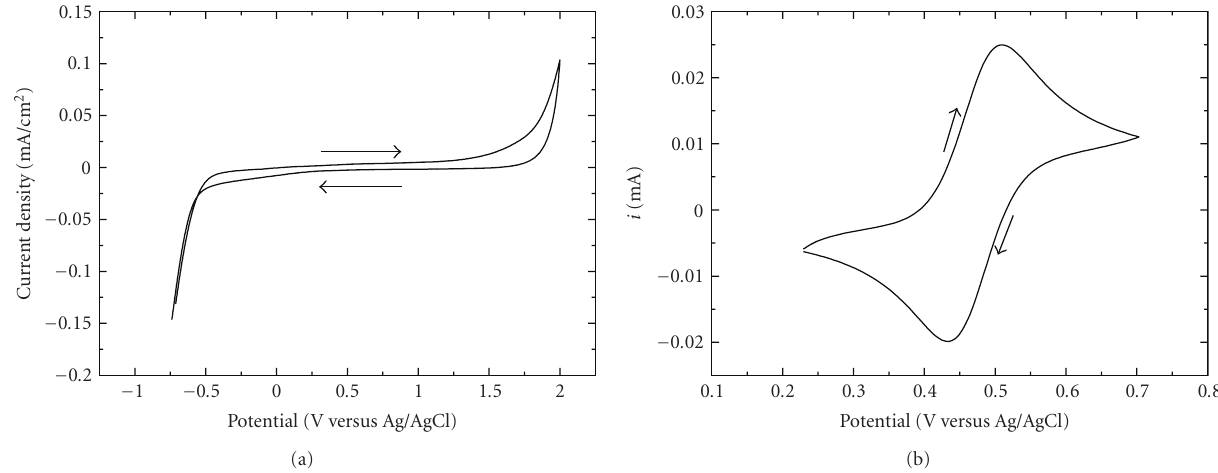
Figure 11: CV i - E curve in (a) 0.5molL − 1 H 2 SO 4 and (b) 1mmolL − 1 ferrocyanide + 0.5 mol L − 1 H 2 SO 4 for BDND electrode. ( ν = 0.1Vs − 1